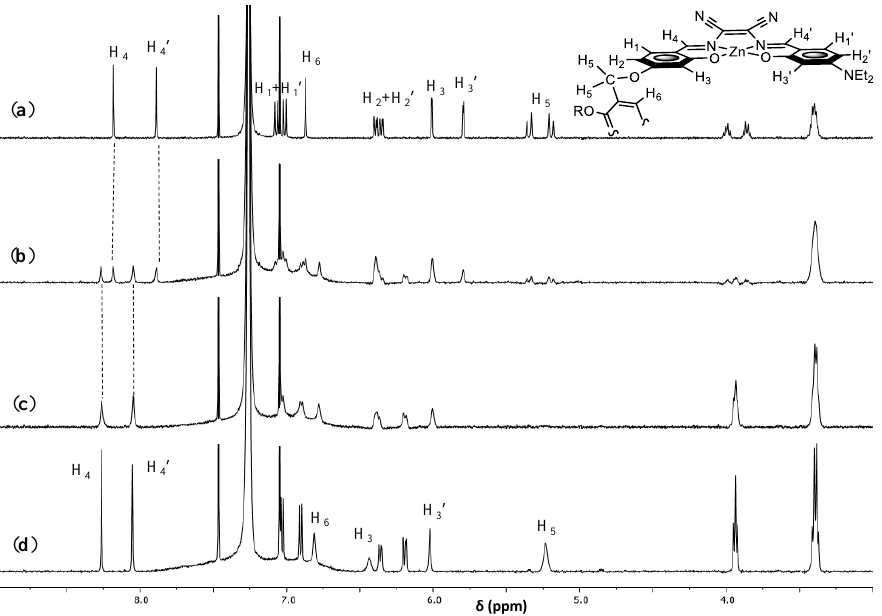
Figure 4. 1 H NMR titration spectra of 1 (50 µ M in CDCl 3 ( a )) with addition of DABCO. The concentration of DABCO added was 25 µ M ( b ), 100 µ M ( c ), and 200 µ M ( d ).